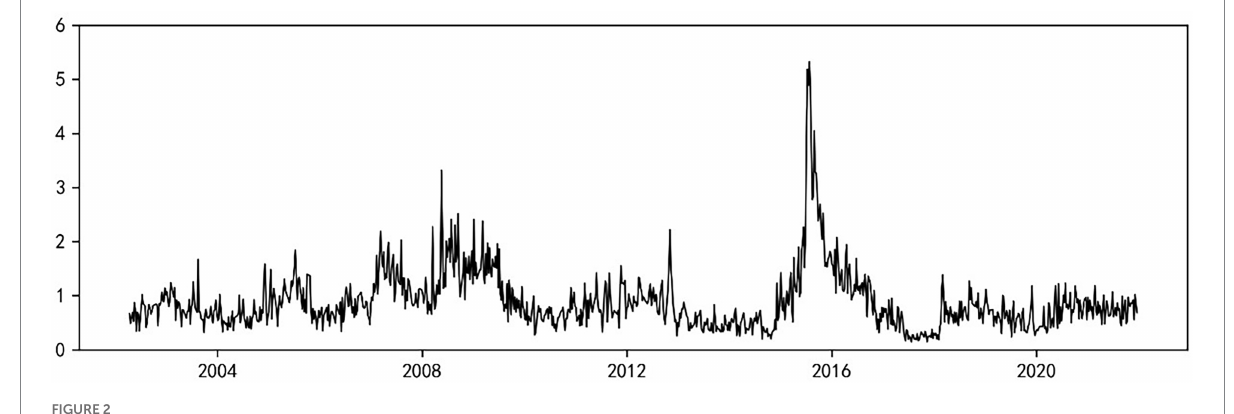
FIGURE 2 Total systemic risk spillover index across sectors.